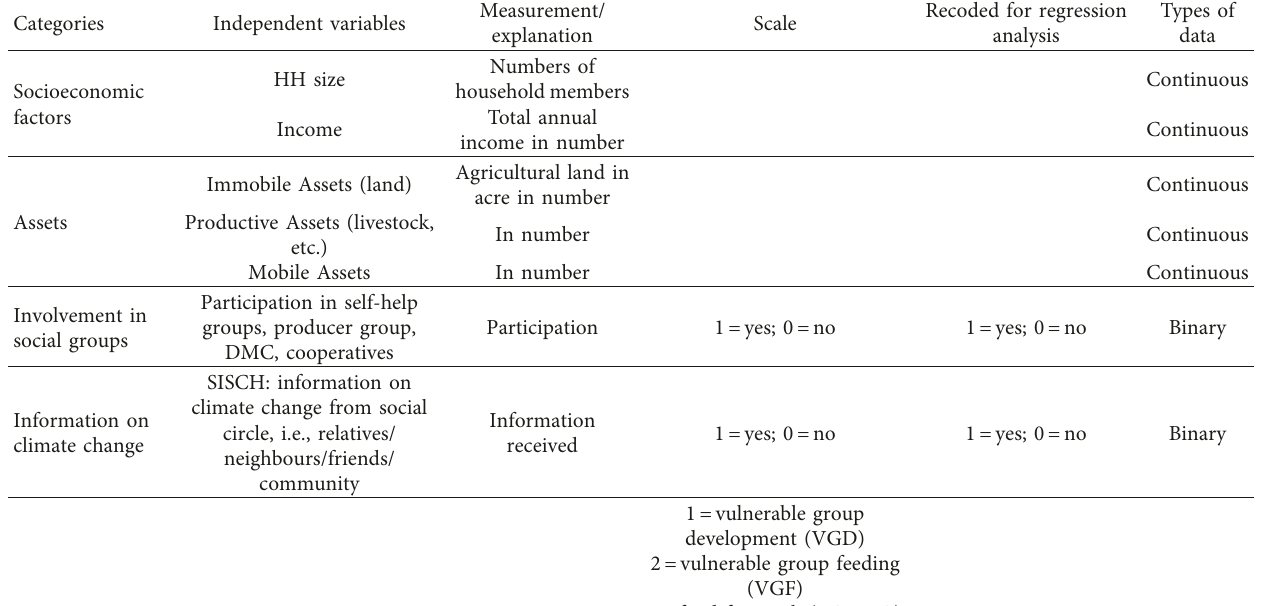
Table 8: Independent variables with details for the dependent variable (overall risk